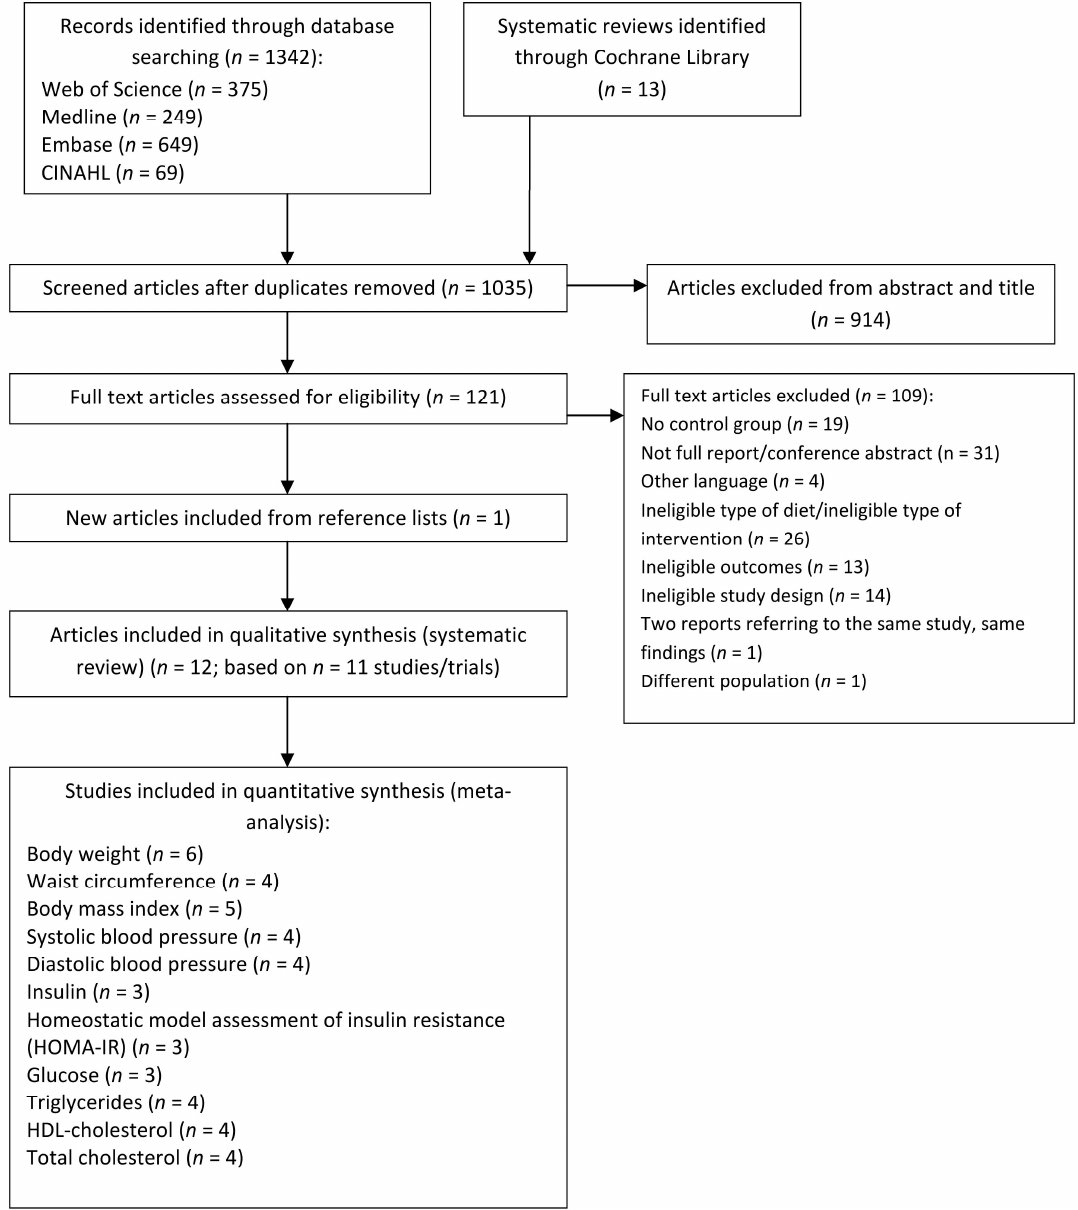
Figure 1. PRISMA flow diagram of literature search and study selection.